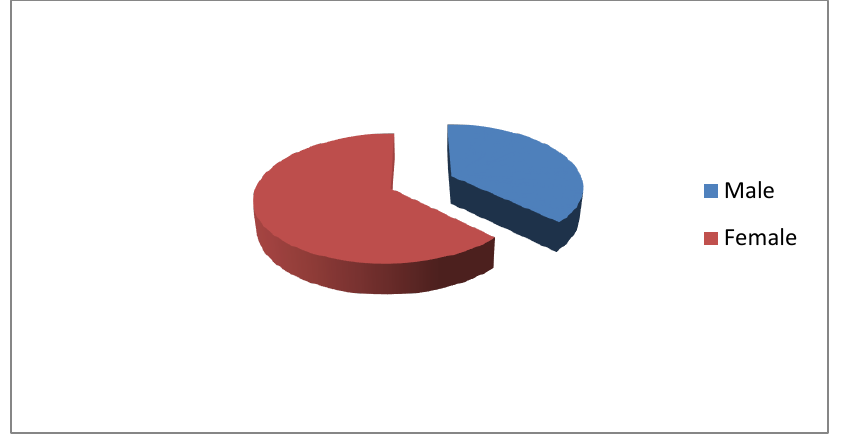
Figure 2. Composition of the gender groups. Figure 3 indicates that the four race groups represented in this sample consisted of 86.3% Blacks